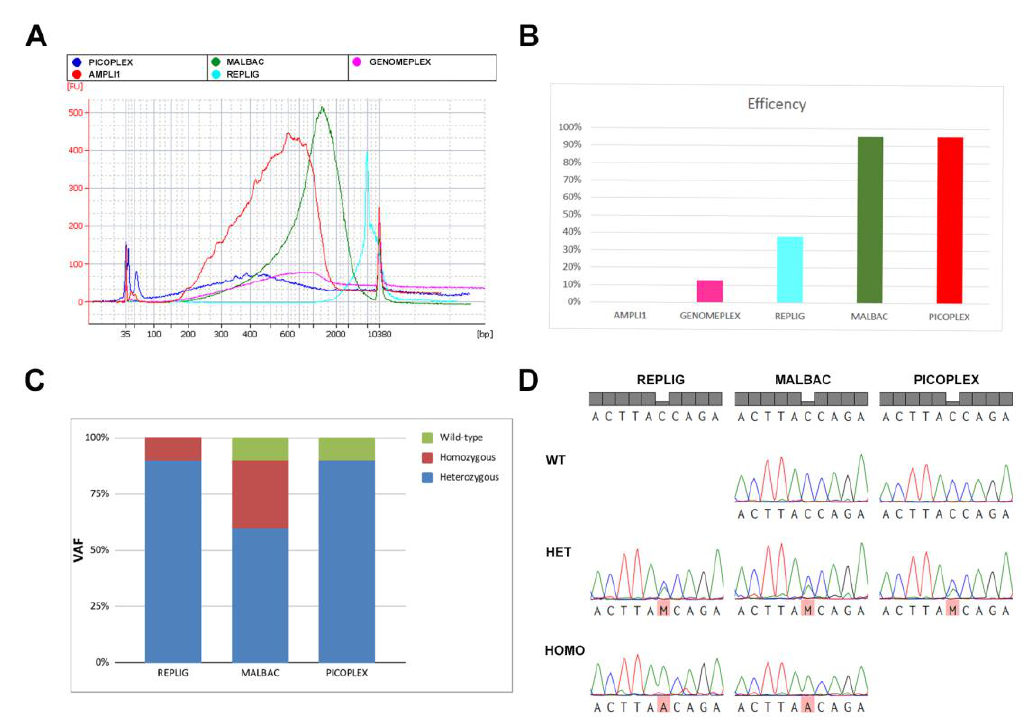
Figure 4. Evaluation of single-cell WGA quality. ( A ) Bioanalyzer profiles of amplified DNA coming from single K562 cells fixed with PFA 0.5% for 15 min. Color code: PicoPlex in red, Ampli1 in blue, Malbac in green, RepliG in light blue and GenomePlex in purple. ( B ) Percentage of sequencing efficiency, performed on a region of the ASXL1 gene, obtained with single-cell WGA kits ( n = 20 cells for each kit). ( C ) Histogram representing the rate of ADO effect obtained with the analysis of the heterozygous variant of ASXL1 gene (c.1773C>G) carried by K562 cell line ( n = 20 cells for each kit). ( D ) Representative peaks of homozygous, heterozygous and wild-type alleles identified using Sanger sequencing. Sequences were obtained by different single-cell WGA kits ( n = 20 cells for each kit) and were related to the heterozygous variant of ASXL1 gene (c.1773C>G) carried by K562 cell line.